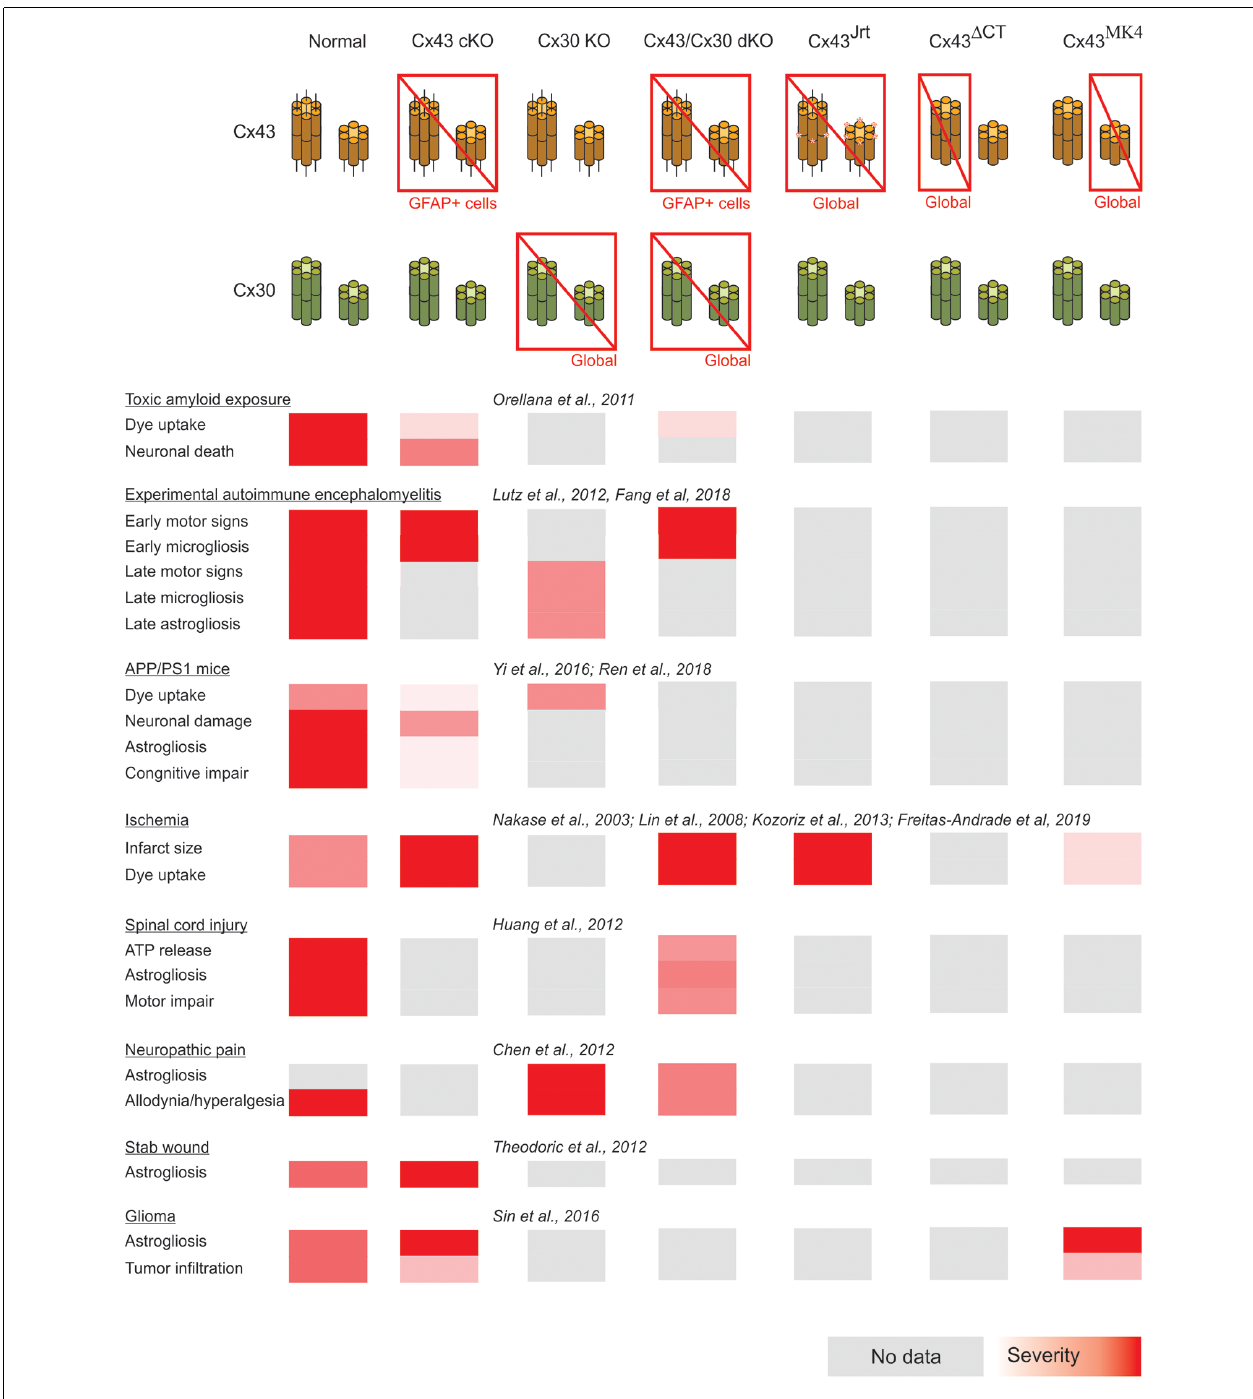
FIGURE 1 | Summary of the impact of global and astrocyte-selective connexin function disruption in the context of in vivo models of central nervous system disease.